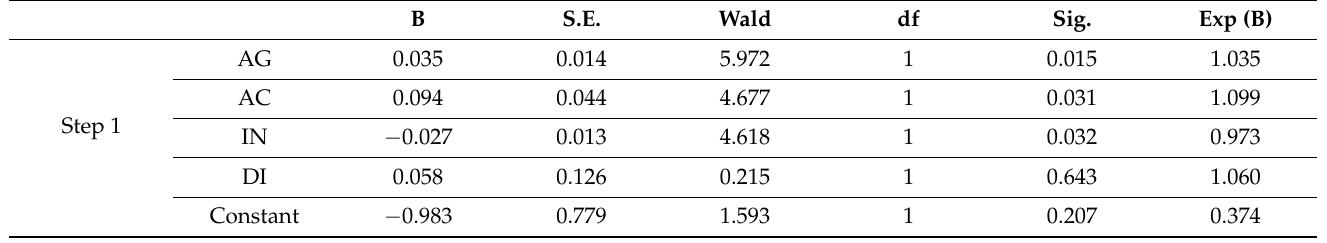
Table 14. Variables in the equation.